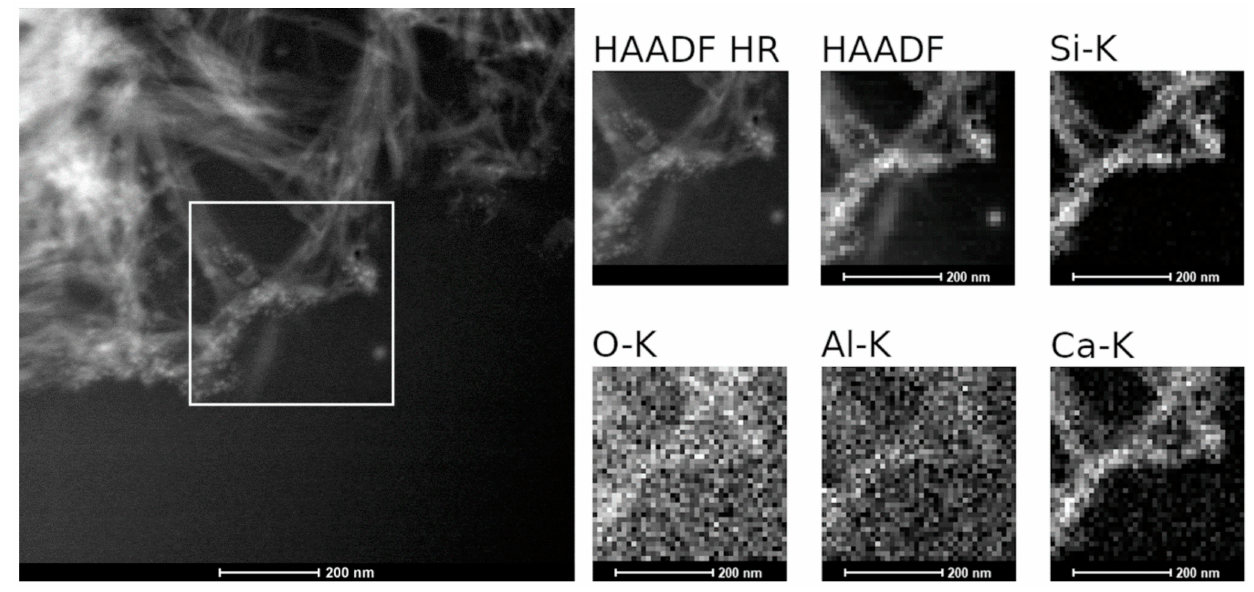
Figure 11. STEM EDS mapping: overview of CSH phases and selected area for EDS mapping. Elemental mappings of Si-, O-, Al-, and Ca-K